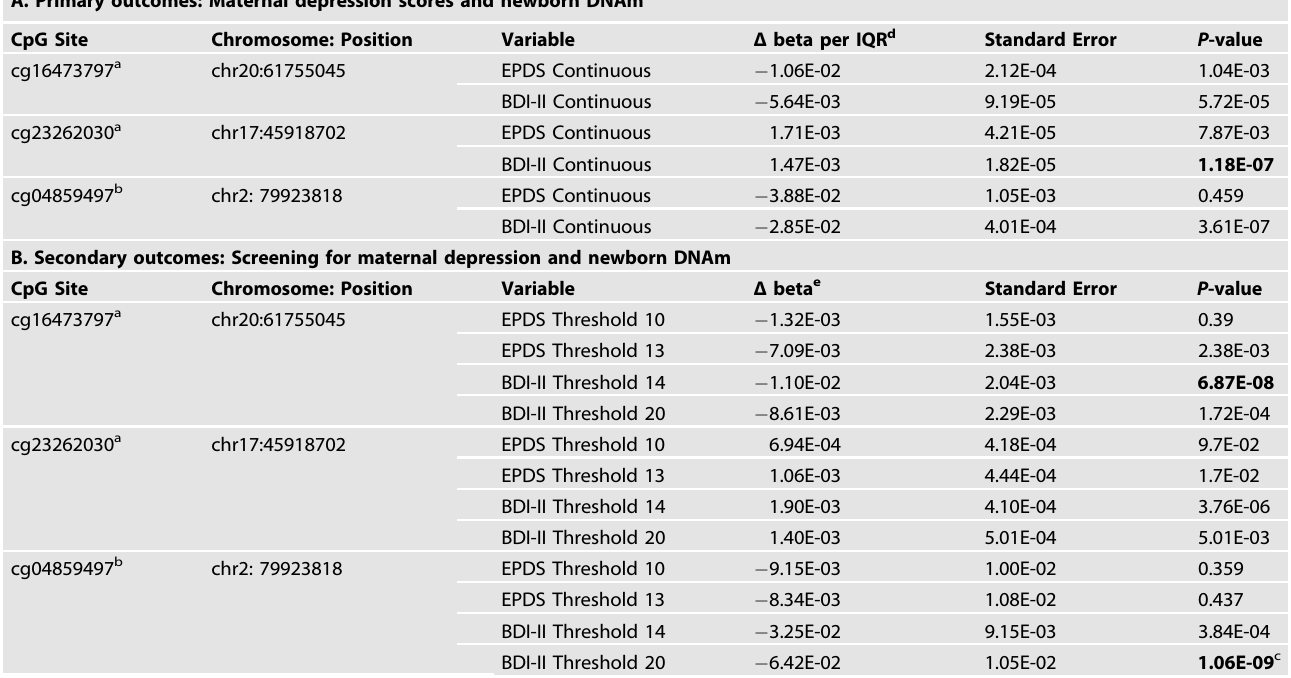
Table 2. Effect sizes and p -values of signi fi cant CpG sites for each depression